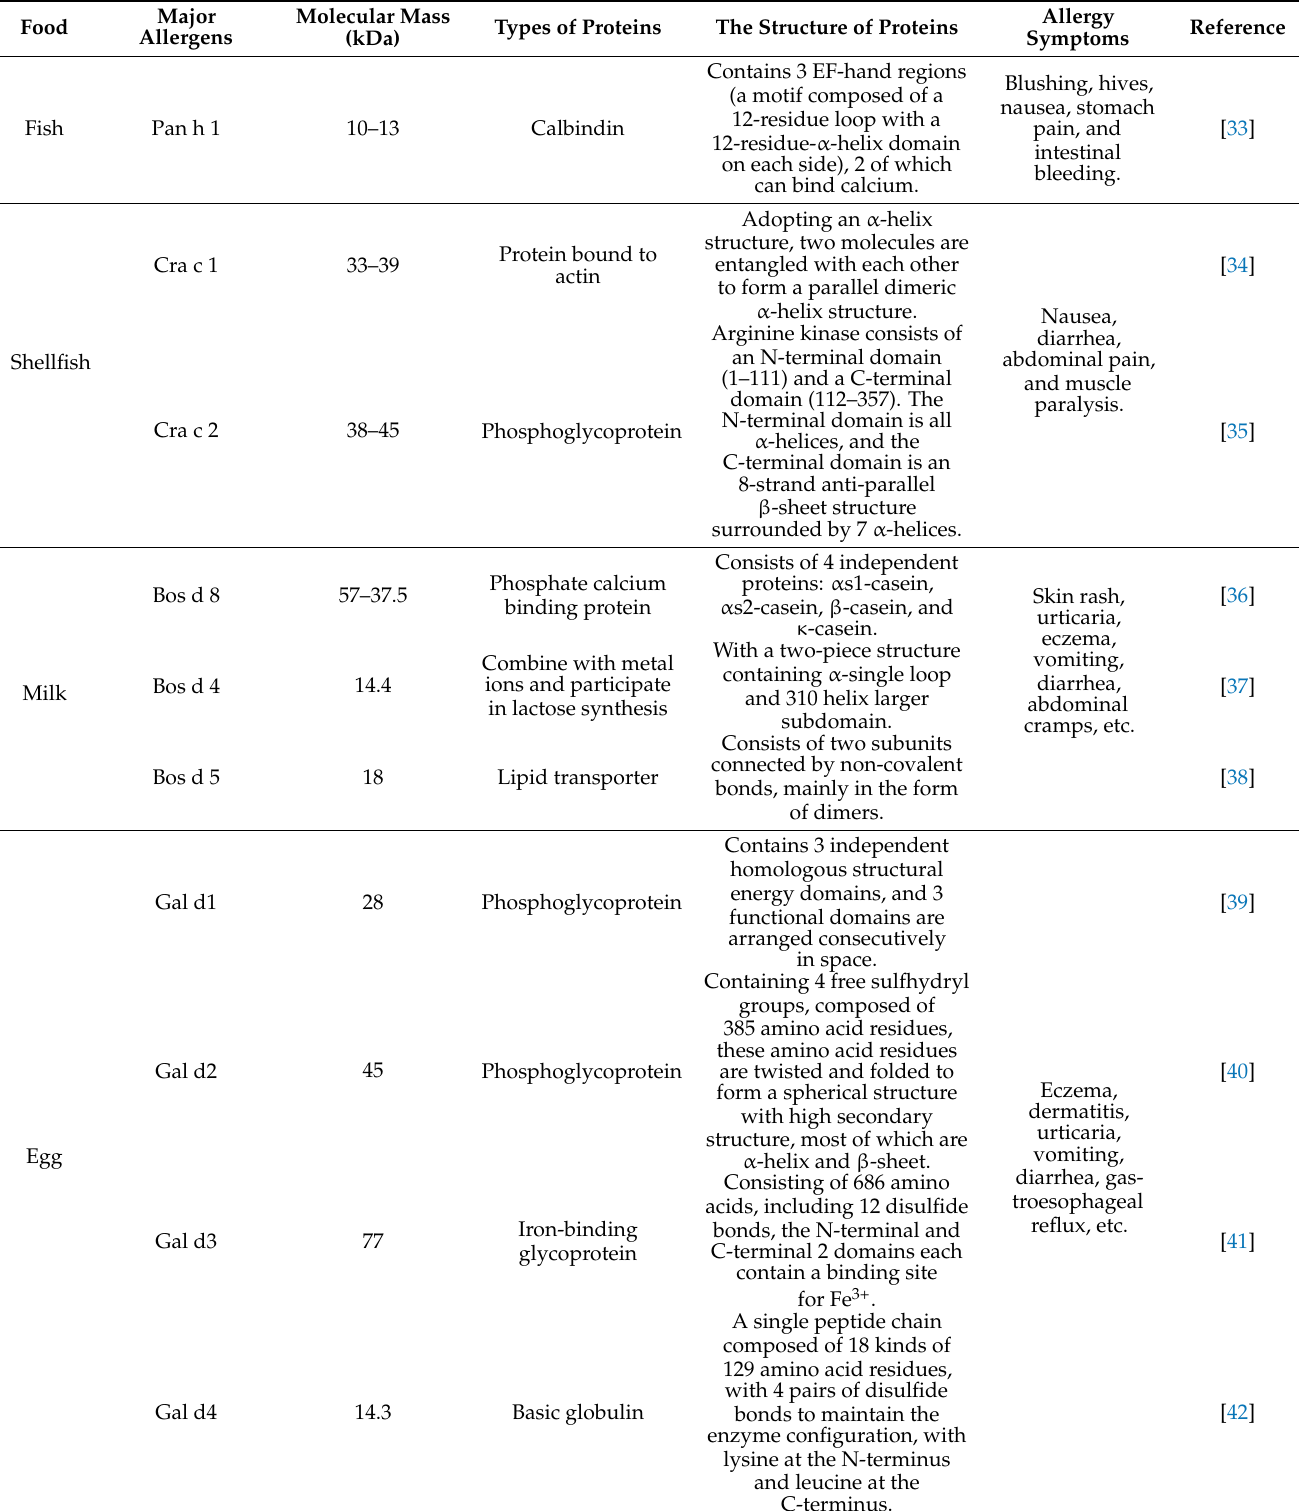
Table 1. The major allergens in food matrices and their allergenic